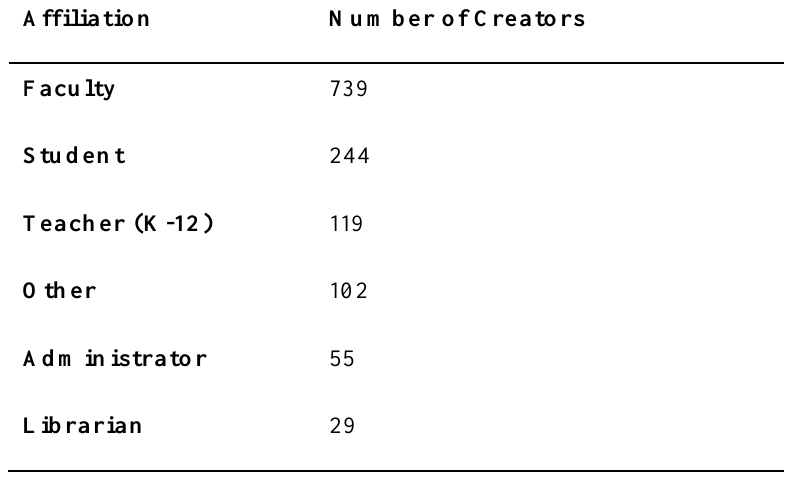
The Affiliation of the Active Groups of Collection Creators